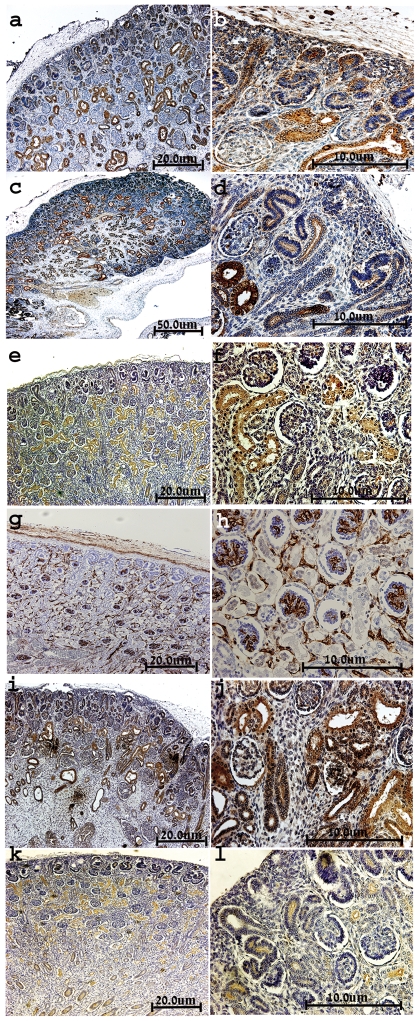
Immunostaining of putative stem cells markers.(a–l) Representative immunostaining of FZD2, GPR39, DLK1, CD34, CD90 and CD24 in paraffin embedded sections of HFK (12, 13 or 18 weeks of gestation); (a–b) FZD2 immunostaining demonstrates widespread staining of renal tubules. (c–d) GPR39 immunostaining demonstrates ubiquitous expression in differentiated renal tubular and to a lesser extent in componenets of the nephrogenic cortex. (e–f) Dlk1 immunostaining demonstrates ubiquitous expression in differentiated renal tubular but not in MM and its derivatives renal, UBs or stroma. (g–h) CD34 immunostaining demonstrates exclusive localization to endothelial cells (glomerular and peri-tubular) in all parts of the HFK, including in the nephrogenic cortex. (i–j) CD90 immunostaining demonstrates predominant staining in renal tubular cells but not in MM and its derivatives, UBs or stroma. (k–l) CD24 immunostaining demonstrates widespread expression in mature tubules. Figure (c) is shown in low magnification (original×4), Figures a, e, g, i, k and b, d, f, h, j, l are shown in higher magnifications (original×20 and×40, respectively).